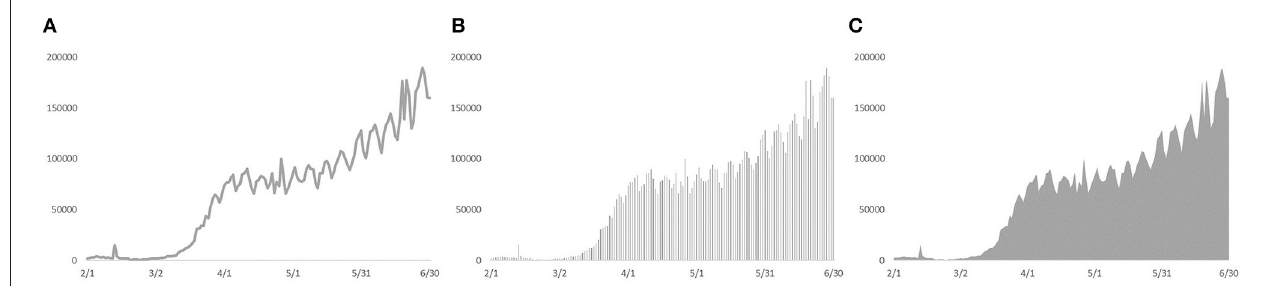
FIGURE 1 | Graphs of daily confirmed cases from Feb 1 to Jun 30, 2020. (A) refers to a line graph; (B) refers to a bar graph; (C) refers to a stacked area graph.